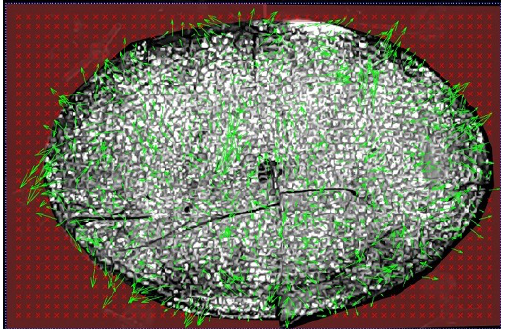
Figure 12. Velocity vectors (green arrows) of the steam flow when the condensate reaches the camera edge. It becomes apparent, by following the direction of the velocity vectors, that condensation occurs on the wall of the chamber. The vector sizes were exaggerated to visualize